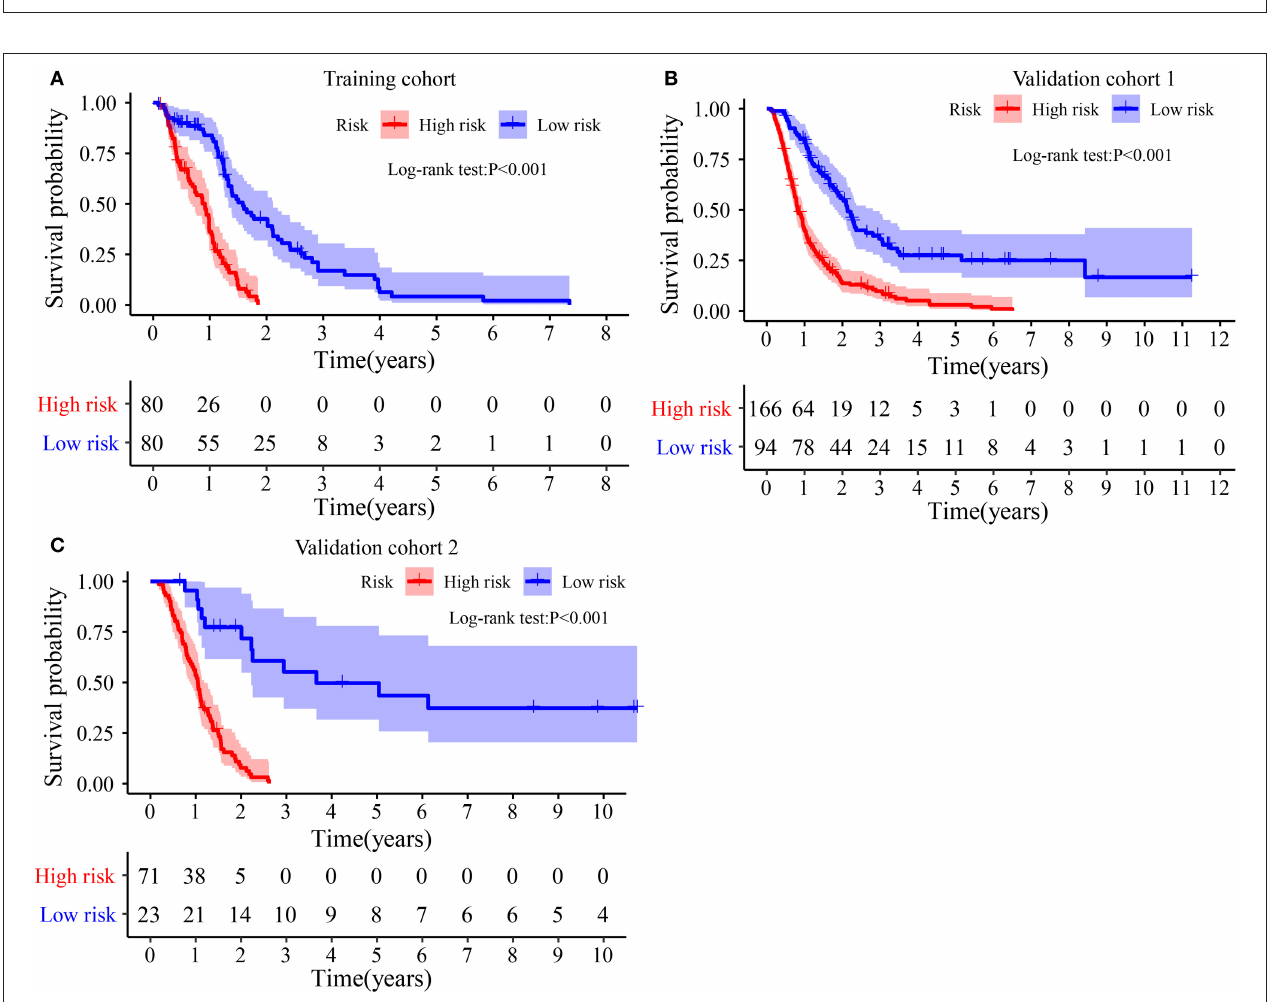
Figure 6F ). Compared with patients without chemotherapy, patients treated with chemotherapy had lower risk scores ( Figure 6H ). However, there was no difference in the